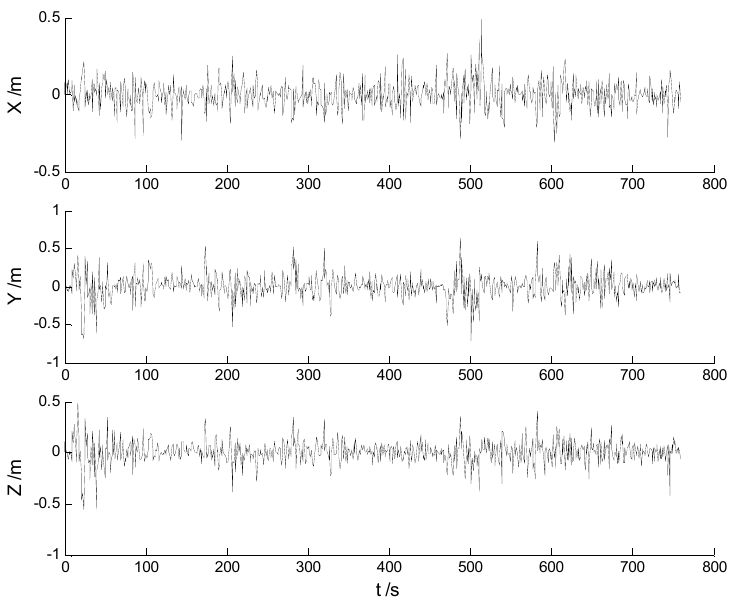
Figure 13. Position errors of the NMHF-CKF algorithm.